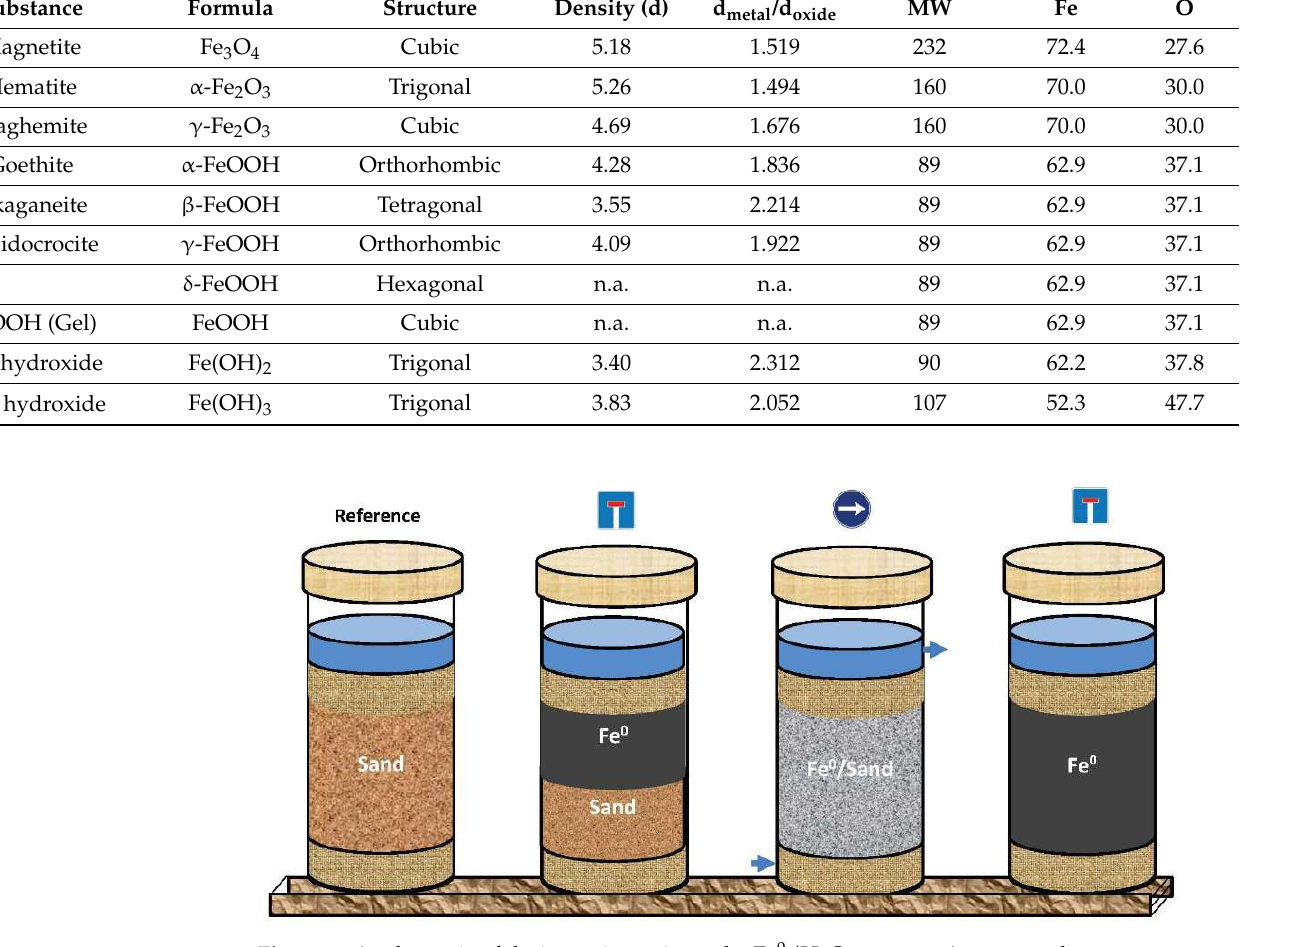
Figure 2. A schematic of design to investigate the Fe 0 /H 2 O systems. A pure sand system can serve as reference, and no pure Fe 0 layer should be considered. Only hybrid and mixed Fe 0 (e.g., Fe 0 /sand) systems are worth investigating both in laboratory and column studies.